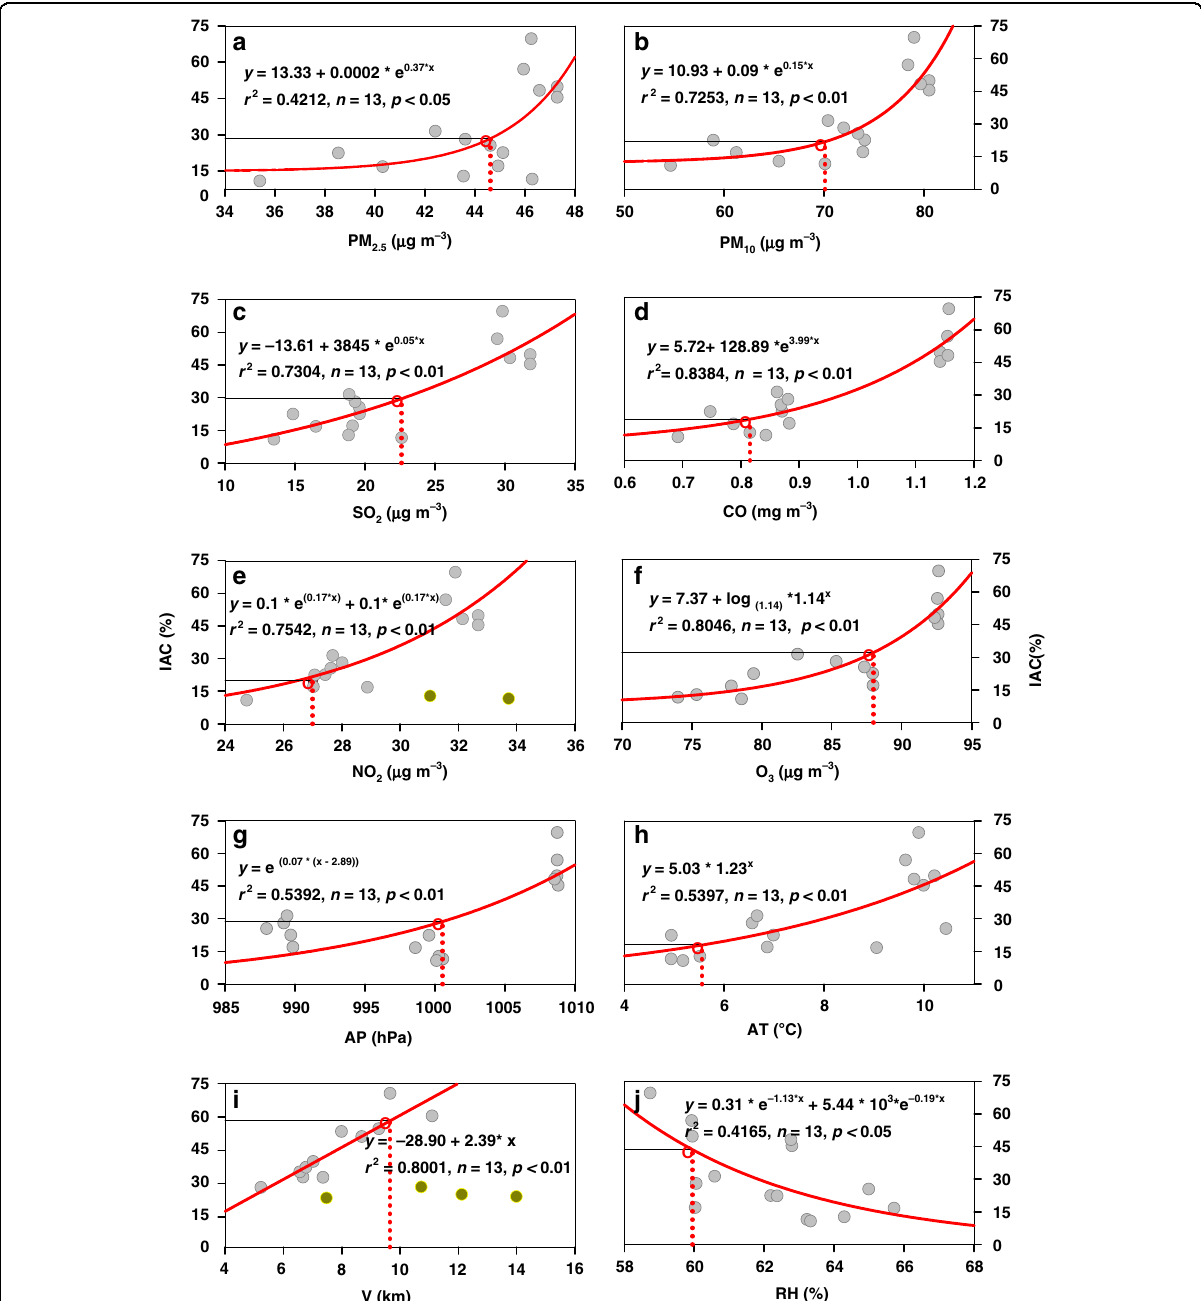
Fig. 5 The linear or nonlinear regression curves between IAC and each environmental factors and their corresponding threshold values (i.e., PM 10 , PM 2.5 , SO 2 , CO, NO 2 , O 3 , Air pressure, Air temperature, Visibility, and Relative humidity) in Northeast China. IAC incidence of allergic conjunctivitis, AP Air pressure, AT Air temperature, RH Relative humidity, V Visibility, PR Precipitation. The gray solid circle is the paired data for the IAC and each factor; the yellow solid circle is outliers that not used in regression analysis; the red hollow circle is the threshold for each